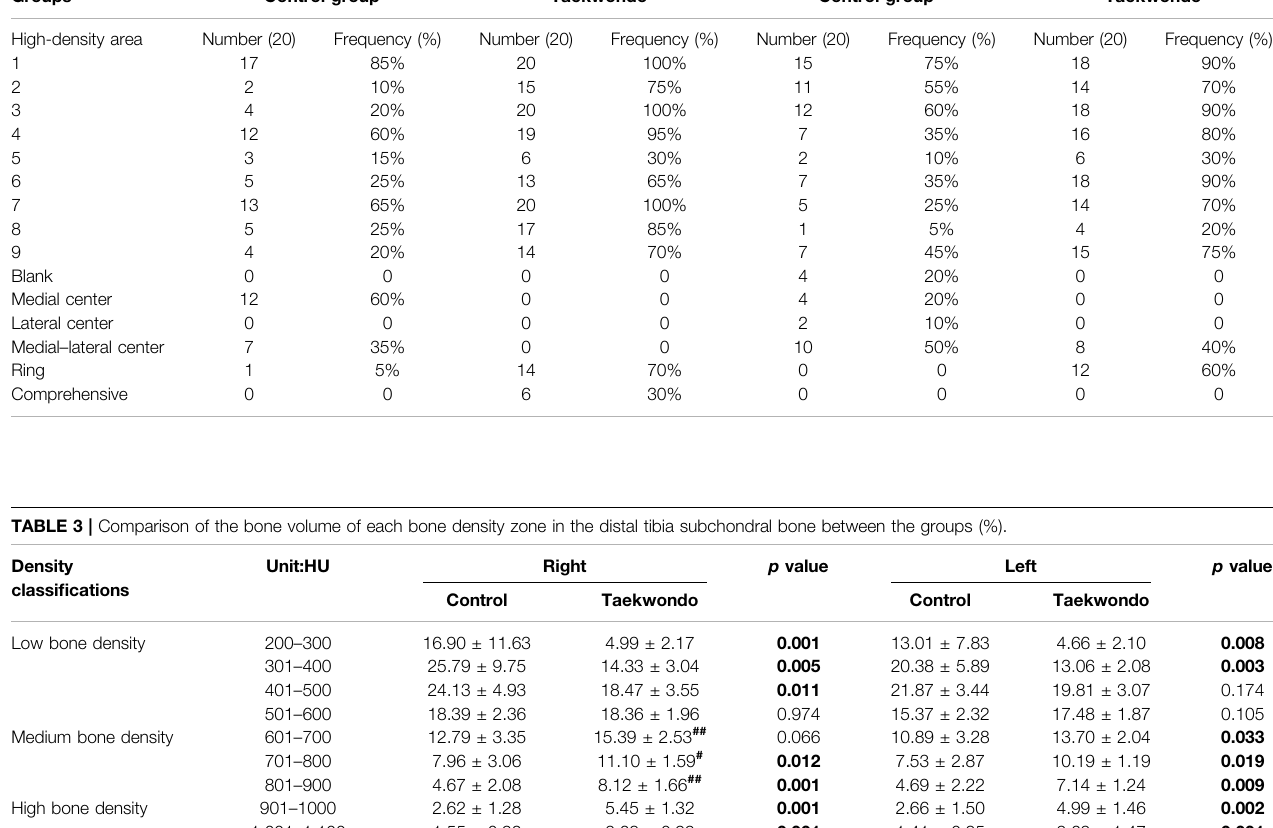
TABLE 2 | Distal tibial articular surface and talus dome high-density area classi fi cation data. Position Distal tibia Talar dome Groups Control group Taekwondo Control group Taekwondo High-density area